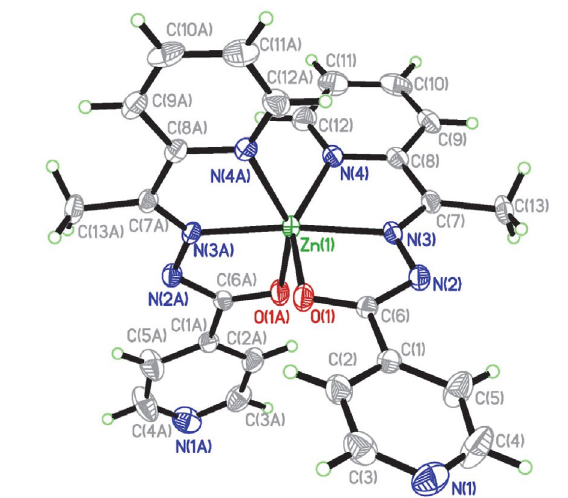
Fig. 1. Perspective view of complex 1 with 30% probability thermal ellipsoids. Atoms labeled with the suffix A are related to the symme- try operation – x , – y , z .